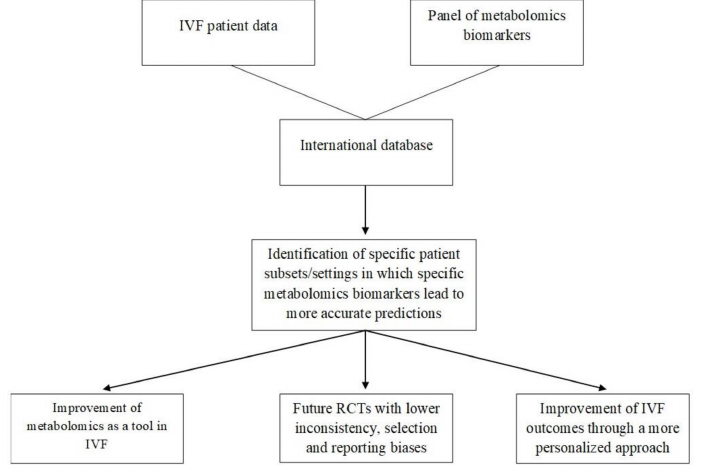
Figure 1. A summary of how a large database of metabolomics biomarkers measured in different IVF populations could potentially elucidate role of metabolomics in IVF and improve IVF outcomes. Abbreviations: IVF, in vitro fertilization, RCTs, randomized controlled